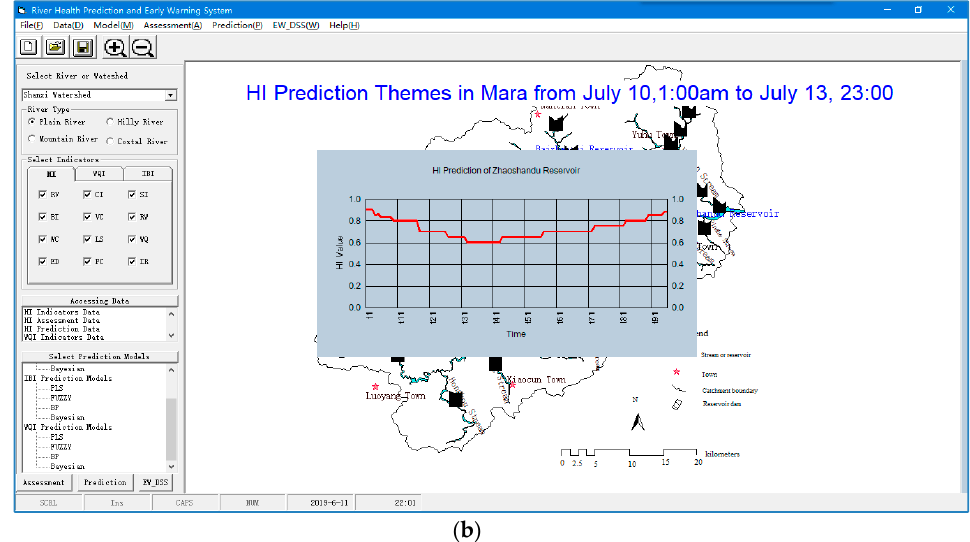
Figure 5. Health index (HI) prediction over the period of Maria: ( a ) HI trend thematic map of all reaches and ( b ) HI trend line chart of Zhaoshandu Reservoir.